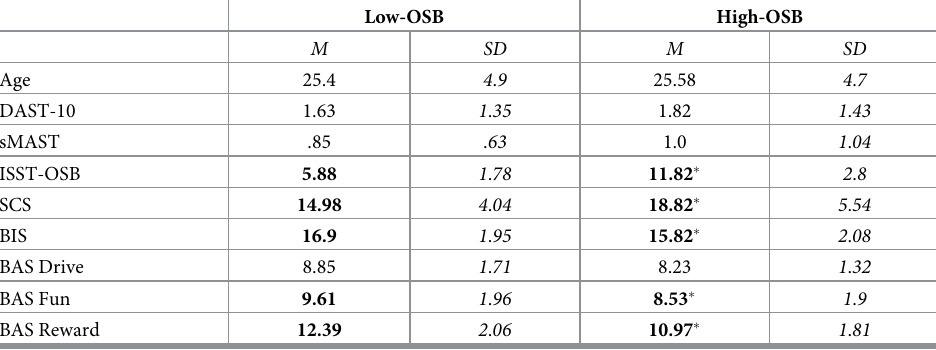
Table 1. Participant characteristics and descriptive statistics for psychometric measures in low- and high-OSB experimental group.